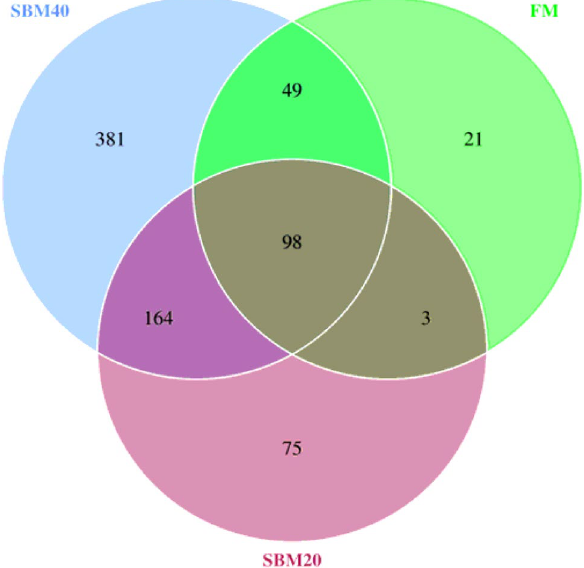
Figure 3. Venn diagram of OUT by high-throughput sequencing after replacing the fish meal with soybean meal in gentian grouper (n = 3).